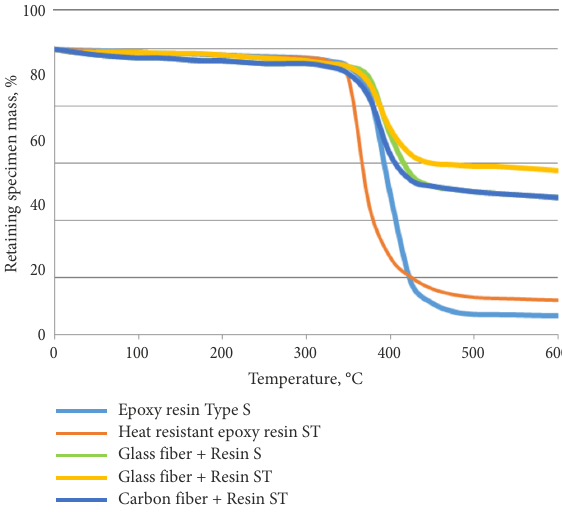
Fig. 1. TGA of epoxy resin samples type S and ST and composite